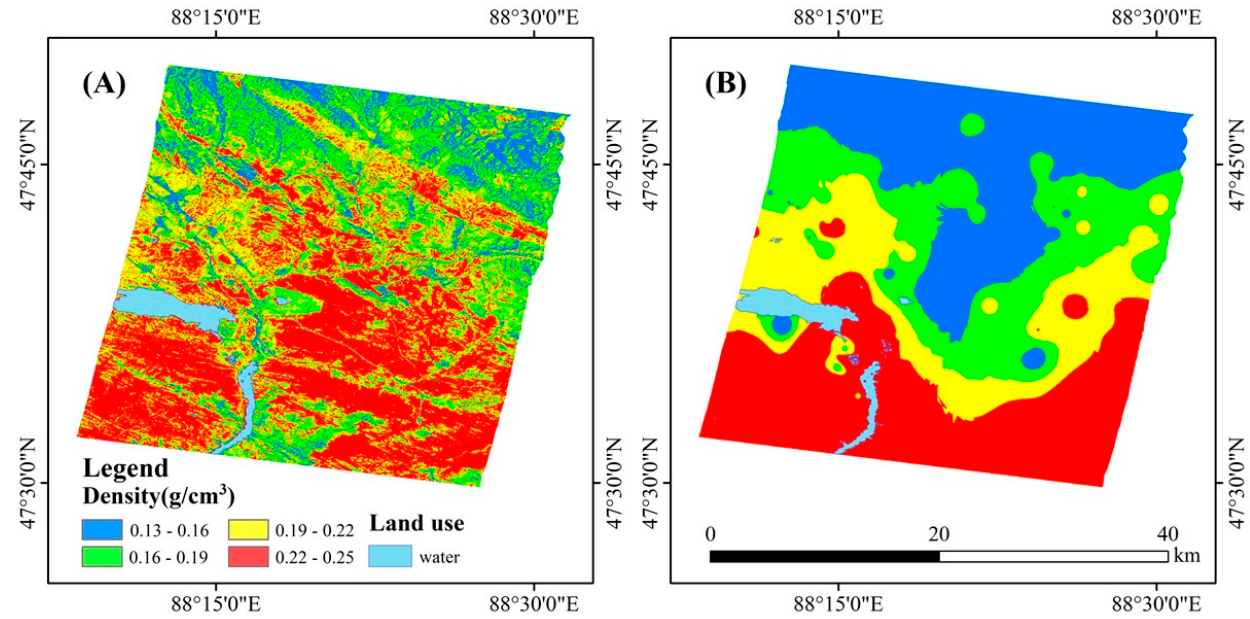
Figure 4. S3H polarization decomposition ( A ) and IDW interpolation ( B ) inversion snow density results.